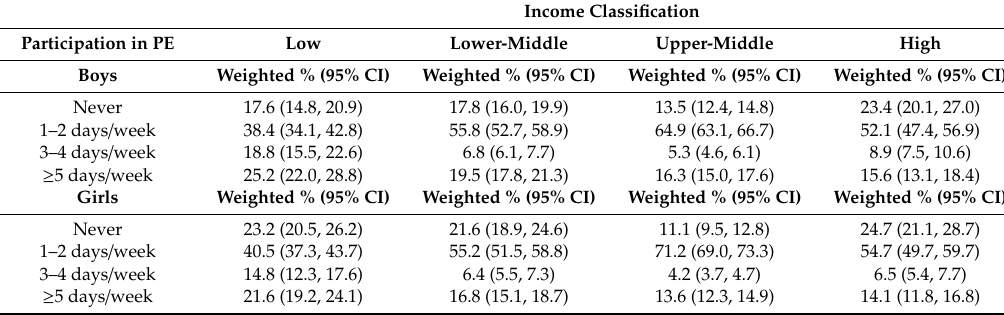
Table 3. Participation in physical education classes according to country income classification, stratified by